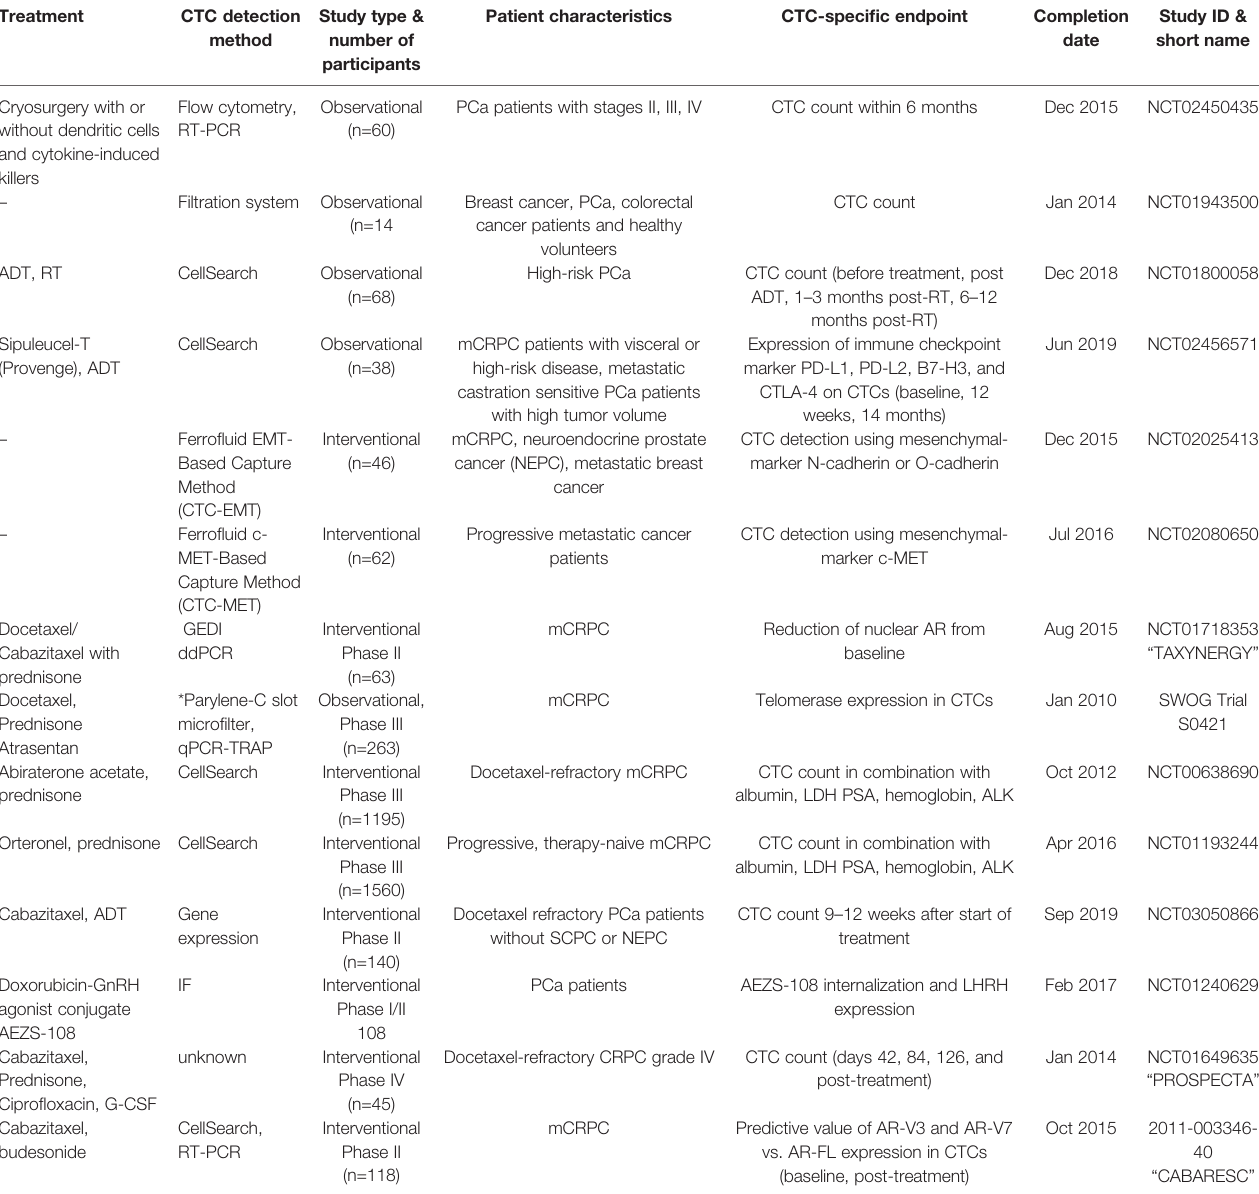
TABLE 2 | Summary of completed clinical trials applying enumeration of circulating tumor cells (CTCs) in PCa patients either as primary or secondary endpoint.